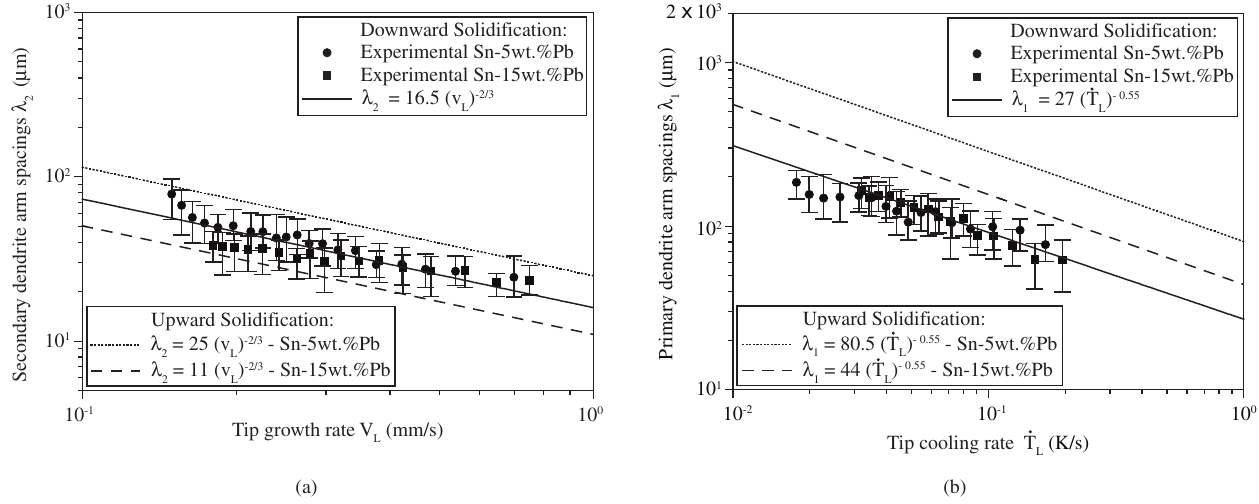
Solidification: Experimental Sn-5wt.%Pb